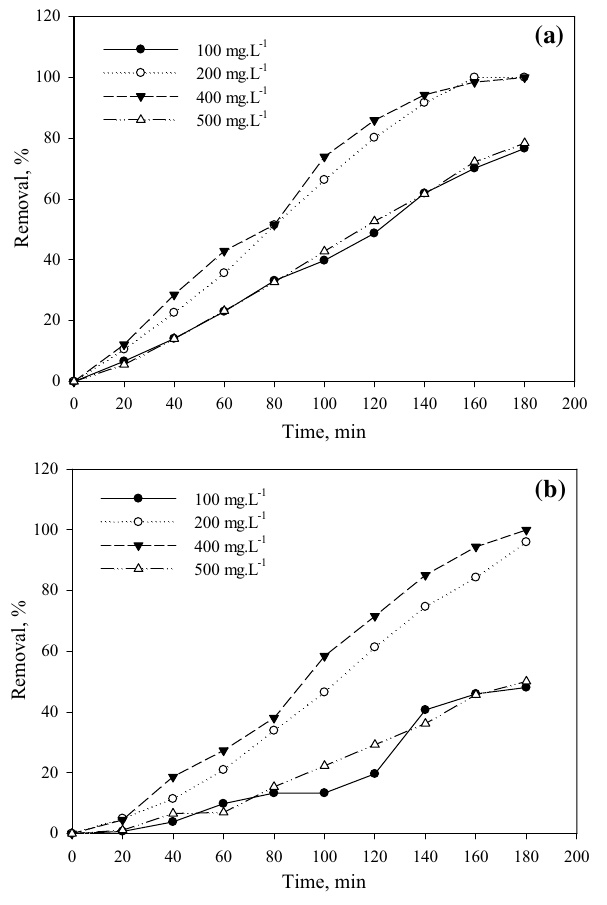
Fig. 9 Effect of initial concentration of methyl orange on the rate bleaching ( a ) and dye degradation ( b ) for pH 6, 200 mg L −1 photo-